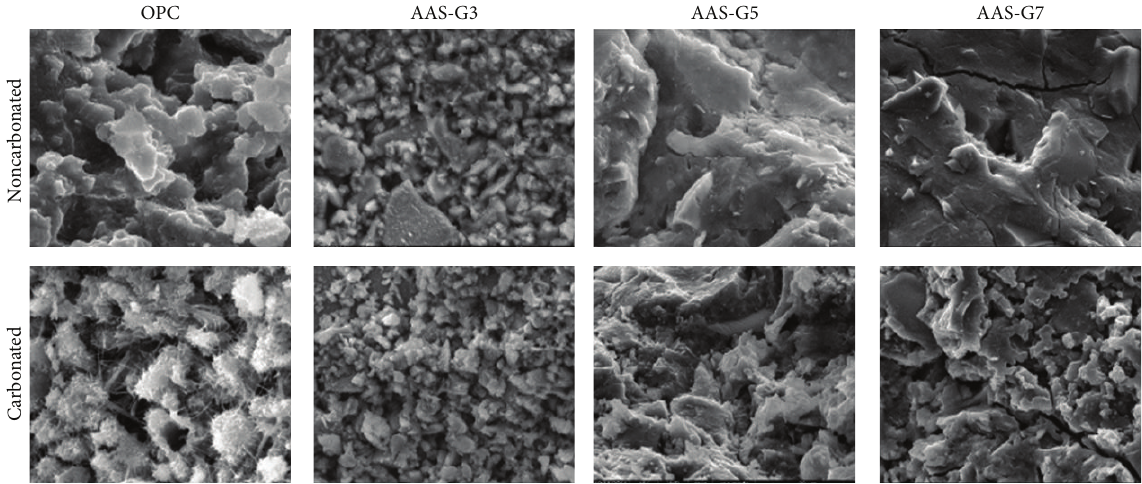
Figure 13: ESEM images ( × 2,000) of noncarbonated and carbonated OPC and AAS mortar with different Na 2 O/S . M ratios.